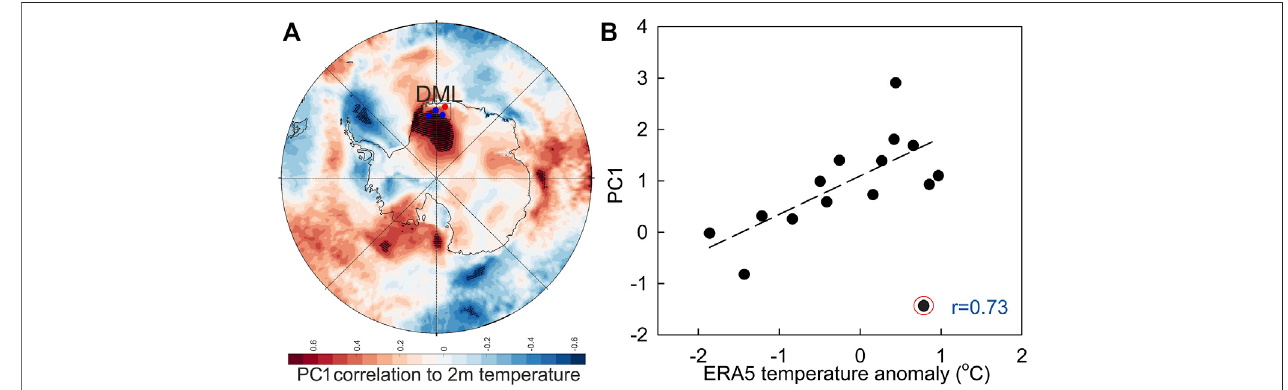
FIGURE 3 | (A) Principal component 1 (PC1) was regressed with seasonal (Nov – Dec – Jan) ERA5 surface air temperature record for the period of 1979 – 1993 CE. Stippling indicates statistically signi fi cant correlations (95% con fi dence level). (B) PC1 shows a signi fi cant correlation with seasonal (Nov – Dec – Jan) ERA5 2m temperature anomaly averaged over the DML region (71.5 ° S to 75.5 ° S; 11.0 ° E to 5 ° W) (r = 0.73, p < 0.05, 1979 – 1993 CE, lag = ~1 year).